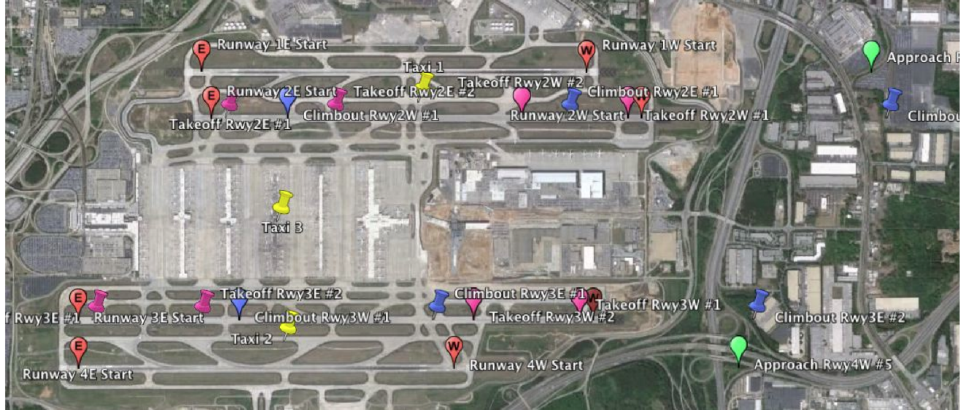
Fig. 1. Hartsfield–Jackson Atlanta International Airport with a subset of emitters as represented in Google Earth. Yellow=taxi mode emitter, pink=takeoff mode emitter, blue=climb-out mode emitter, green=approach mode emitter. Red “E” and “W” markers are reference points at the ends of the runways relative to which emitters are